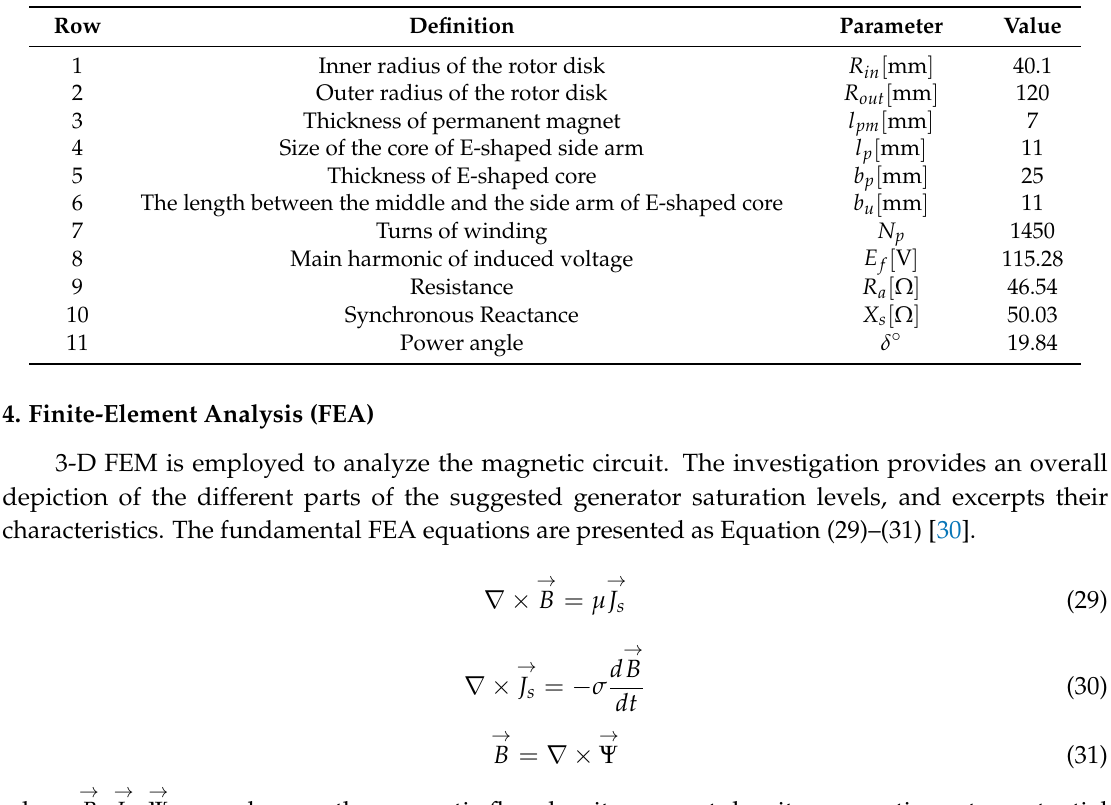
Table 4. Machine’s dimensions and computational